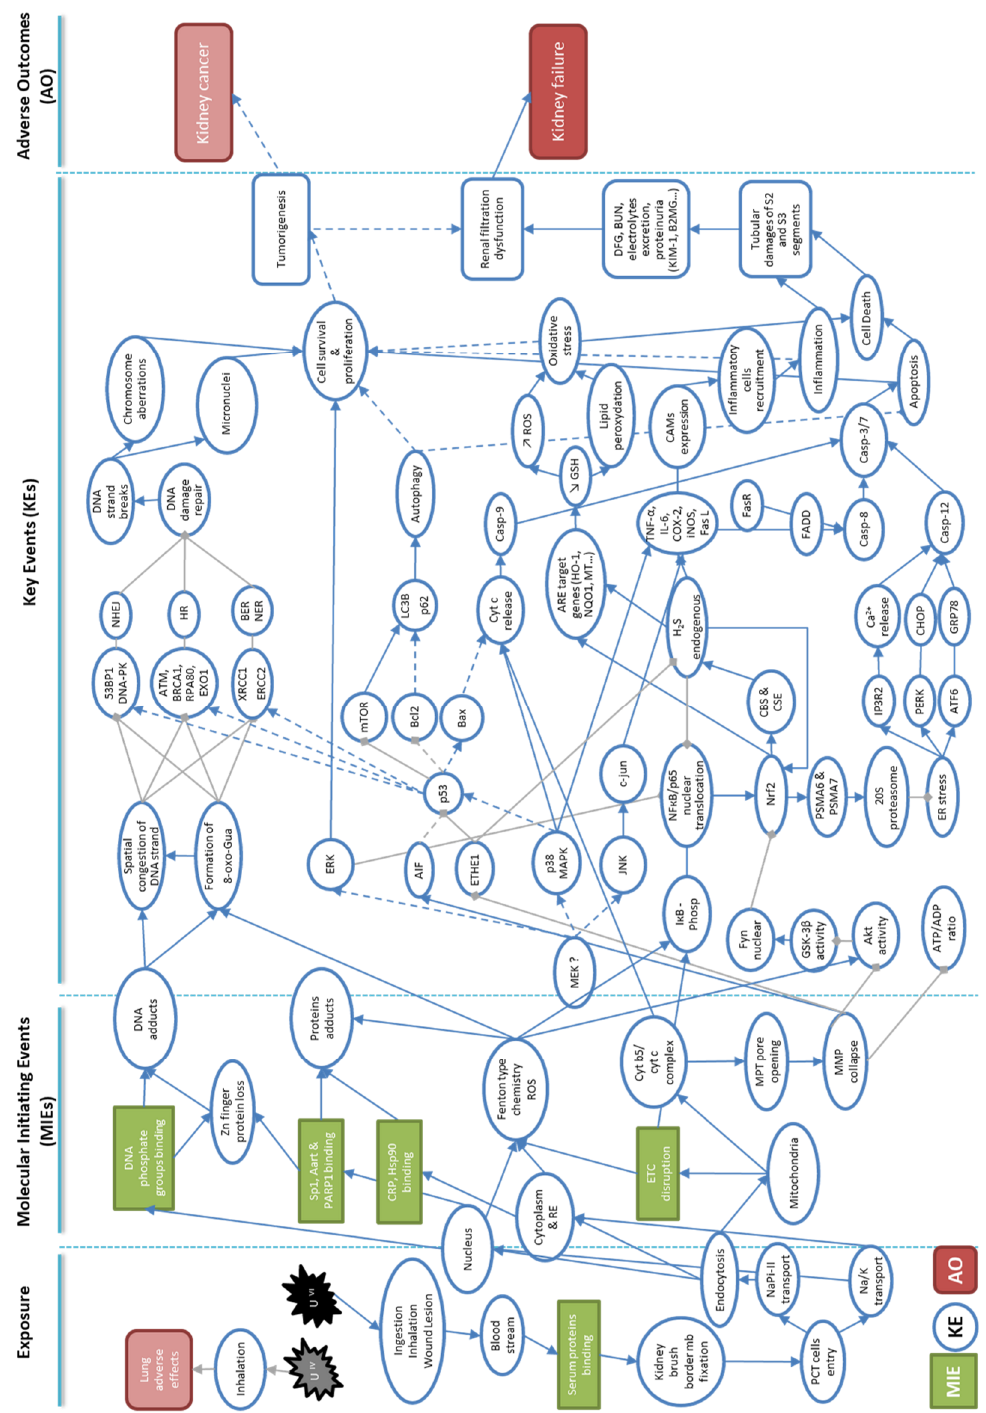
Figure 2. Representative network of identified molecular and cellular key events leading to adverse outcome pathways used in the development of an AOP to kidney failure in the context of U-exposure. Molecular initiating events (MIEs) are represented in green rectangles, and key events (KEs) in blue circles. Finally, the resulting adverse outcomes (AOs) are represented in red rectangles. Filled blue arrows are proven links of induction based on experimental or epidemiological studies of U nephrotoxicity, and gray segments represent links of inhibition. Dotted blue arrows represent hypothetical links that exist between the different key events.